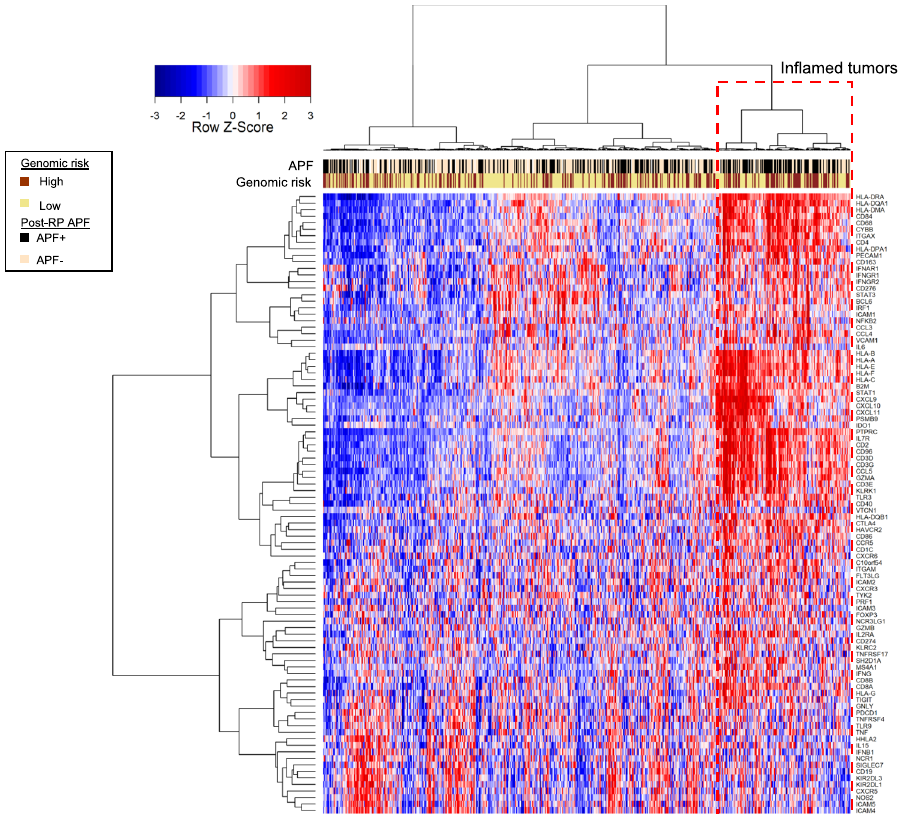
Fig. 5 Tumor in fl ammation heterogeneity in AAM. Using a set of 124 in fl ammation and immune-response genes in AAM, consensus clustering revealed a cluster of patients with high expression of immune genes ( CD3, CD45, GZMA, B2M, STAT1 ), nominating this cluster for immunotherapy treatment intervention. AAM African-American men, APF adverse pathology